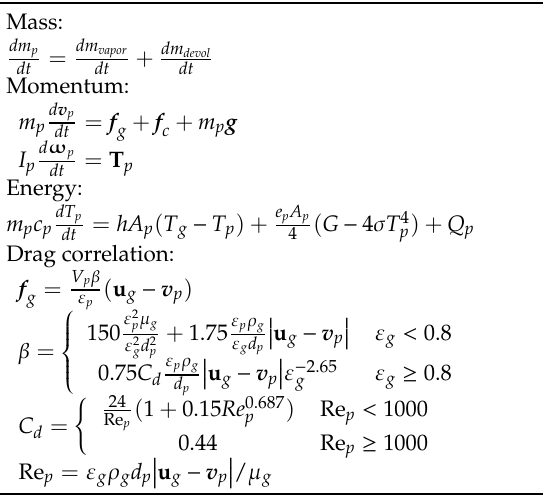
Table 2. Particle phase governing